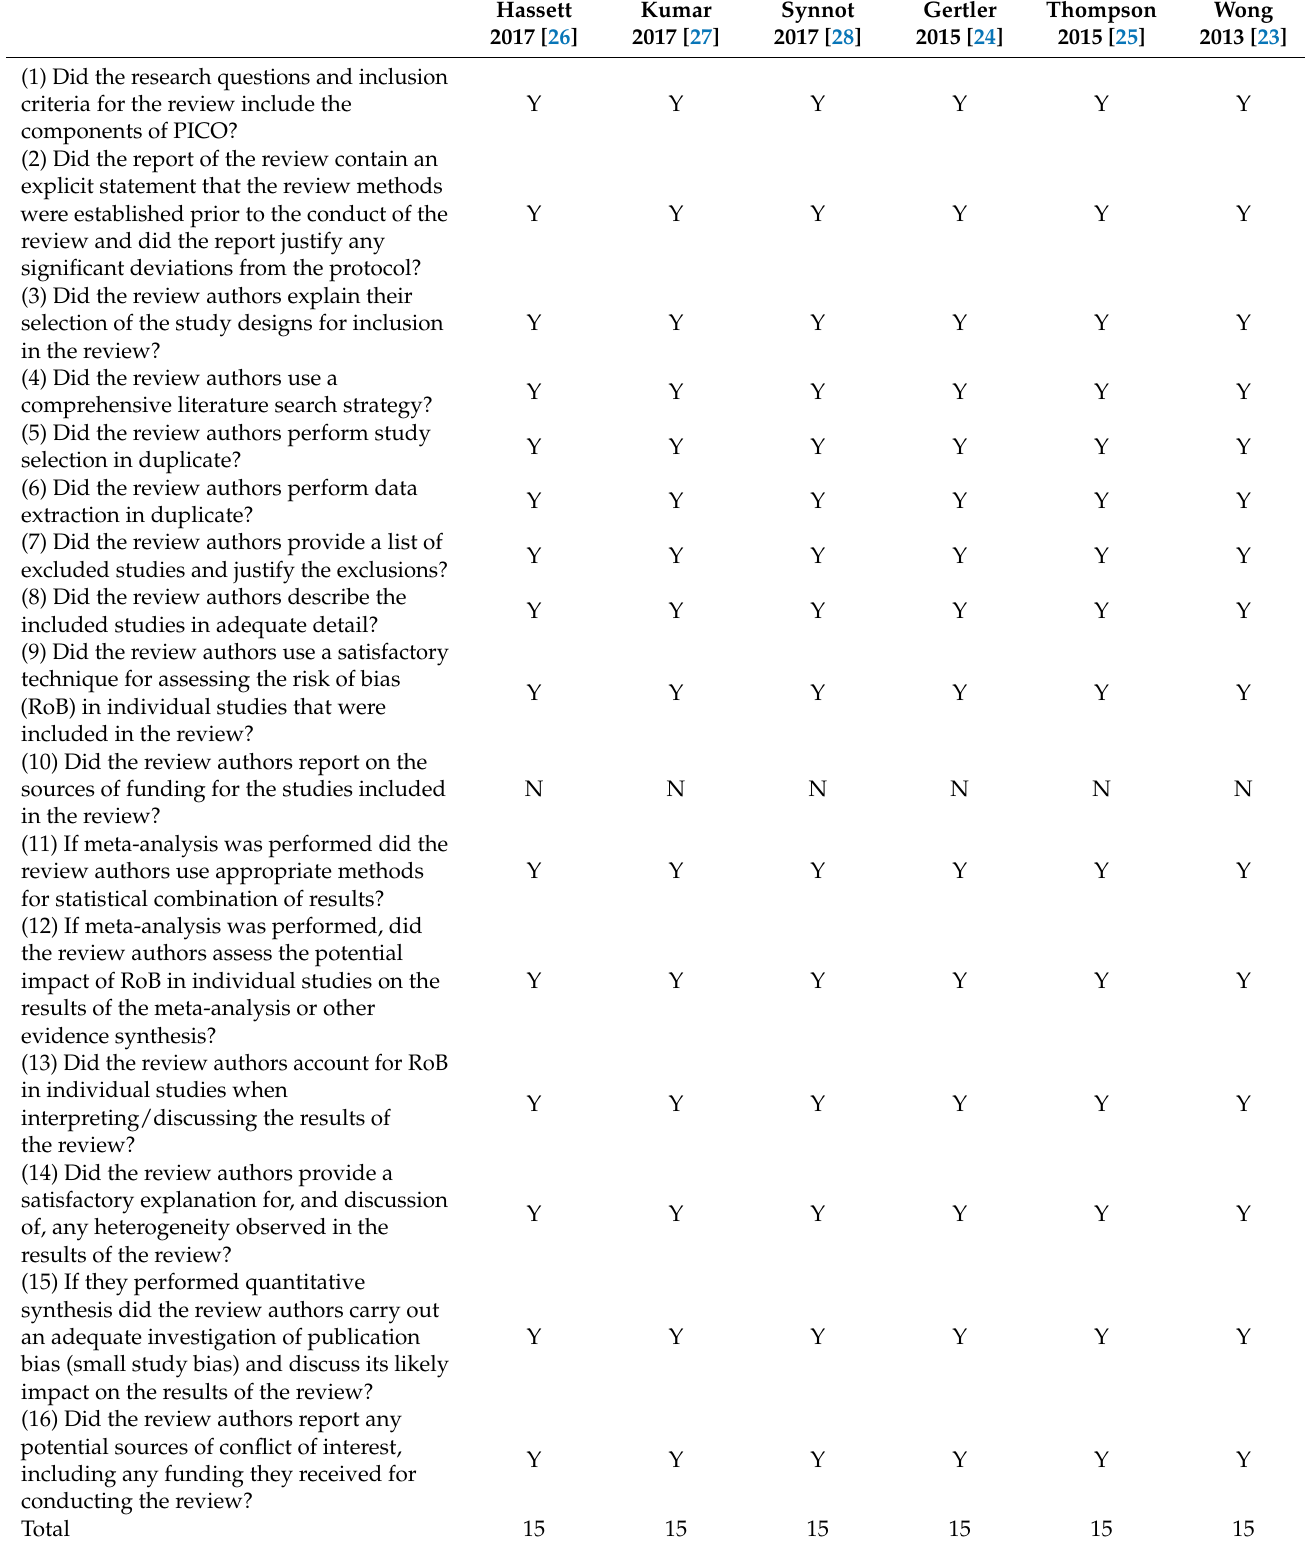
Table 2. AMSTAR 2 Quality Assessment of Cochrane Systematic